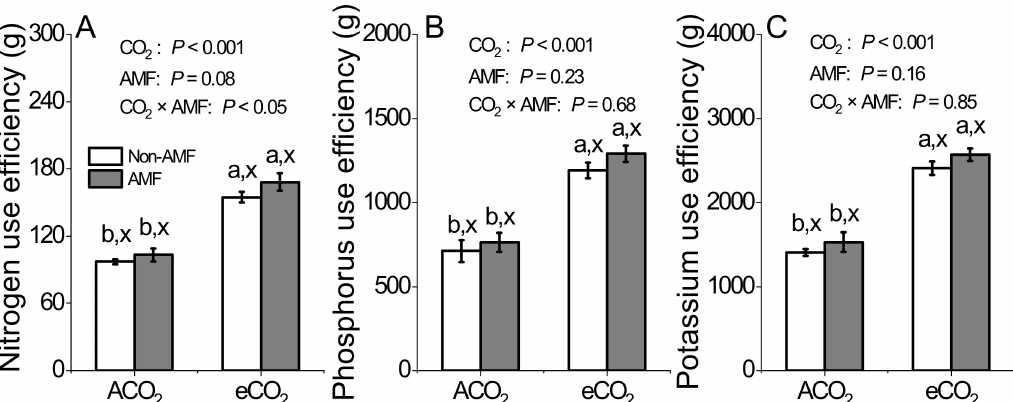
Figure 3. Nirogen ( A ), phosphorus ( B ), and potassium ( C ) use efficiency in the total plants of Funneliformis mosseae inoculated faba beans grown for 12 weeks at ambient CO 2 (ACO 2 ) and elevated CO 2 (eCO 2 ). Data (means ± SE, n = 3) followed by different letters indicate significant differences between CO 2 treatments for the same AMF inoculation (a,b) and between AMF inoculations for the same CO 2 treatment (x, y) at P < 0.05 as revealed by Tukey’s test. Statistical comparisons (two-way ANOVA) between AMF or CO 2 treatments as well as their interaction (AMF CO 2 ) are presented for each variable.